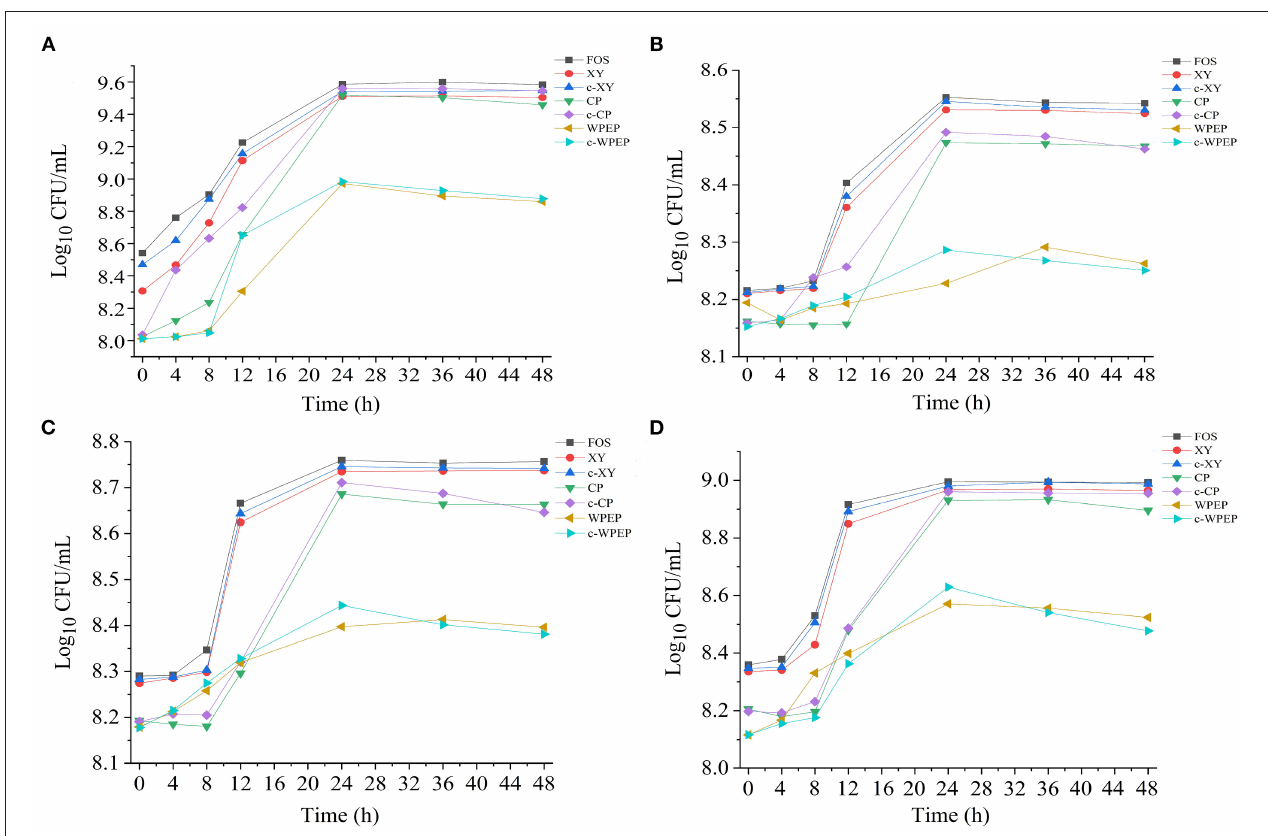
FIGURE 6 | Effects of polysaccharide samples on the growth of (A) L. brevis , (B) L. plantarum , (C) L. delbrueckii subsp. bulgaricus , and (D) S. thermophilus